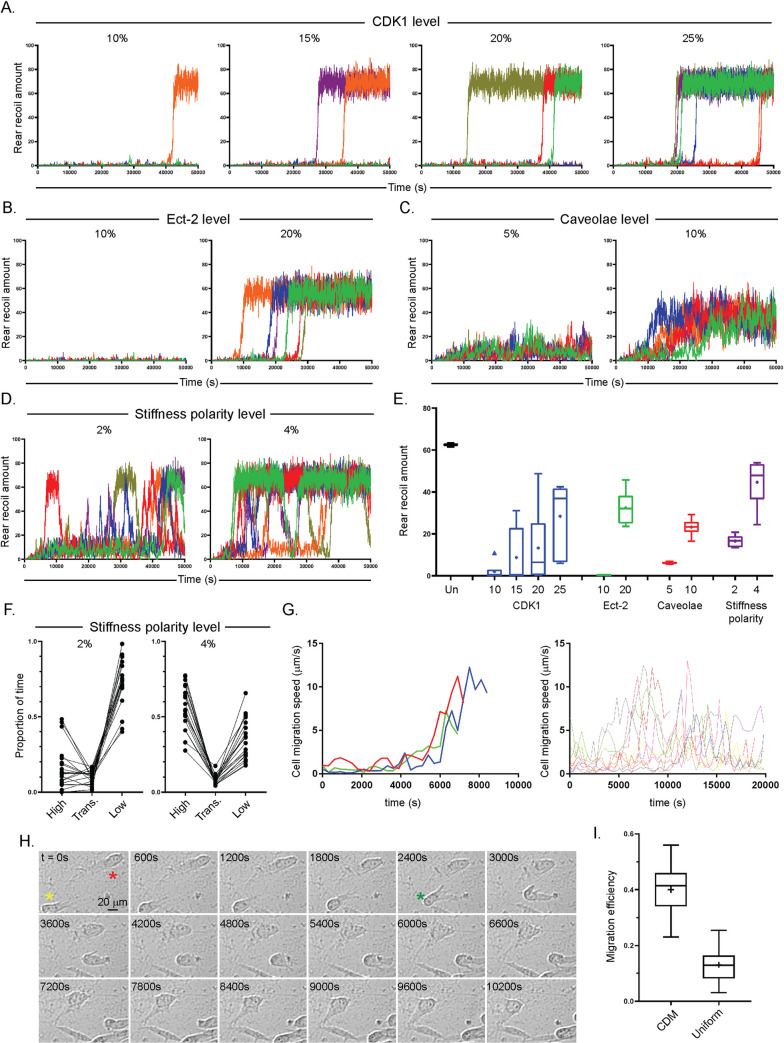
Stochastic simulations of the CDK1-included model recapitulates previous perturbation dynamics and predicts real cell behaviour in A-D.6 stochastic simulations of the CDK1-included model showing the timecourse for the first 50,000s of rear retraction amounts with: A. different CDK1 amounts, ranging from 10% (left) to 25% (right) of the unperturbed value; B. Ect-2 amounts at 10% (left) and 20% (right), C. caveolae amounts at 5% (left) and 10% (right); and D. substrate stiffness polarity at 2% (left) and 4% (right). E. Average rear retraction amount of all 6 simulations across the whole 50,000s for unperturbed (denoted un), and each level of CDK1, Ect-2, caveolae and substrate stiffness polarity perturbation simulations. Note each individual simulation was averaged first and then the data of the 5 cells shown as a Tukey box plot, such that the spread corresponds to the spread between overall rear retraction amounts between different simulations (not the spread between values at different time points). F. Proportion of time of the 50,000s timecourses rear recoil amount spent in the high state (defined as rear recoil > 50%), the low state (< 20%) or transitioning (trans.) between (>20%, <50%) of 20 simulations with substrate stiffness polarity set at 2% (left) or 4% (right). G. Experimental automated tracking data of (Left) 3 A2780 cells starting from an unpolarised state, showing the instantaneous migration speed with respect to time, up until maximum rates of migration speed are reached or (right)10 randomly selected A2780 cells across 3 repeats showing instantaneous migration speed with respect to time across the whole time course or until cells go out of view. Cells were spread on CDM and imaged within 1 hour. H. representative montage images of polarised A2780 cells every 600s across 10,800s, yellow star denotes a fast moving cell which undergoes a particular rapid phase of rear retraction at between t = 2400s and t = 3000s (denoted by green star), red star denotes a slower cell which has travelled much less distance in the same time period. I. Cell migration efficiency, defined as directional persistence x speed of A2780 cells in CDM compared to on uniform plastic. Cells were imaged by high-end widefield microscopy across 16 hours; Average speed of cells in each condition shown (N = 70 cells across 3 repeats analysed per condition). **** denotes p < 0.0001 by unpaired student t-test.